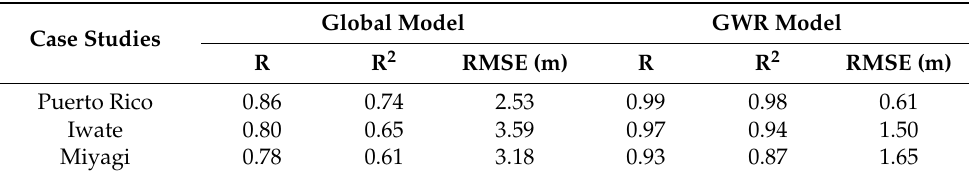
Table 2. Comparison of accuracy of SDBs generated by global model and GWR model case studies 1, 2, and 3.